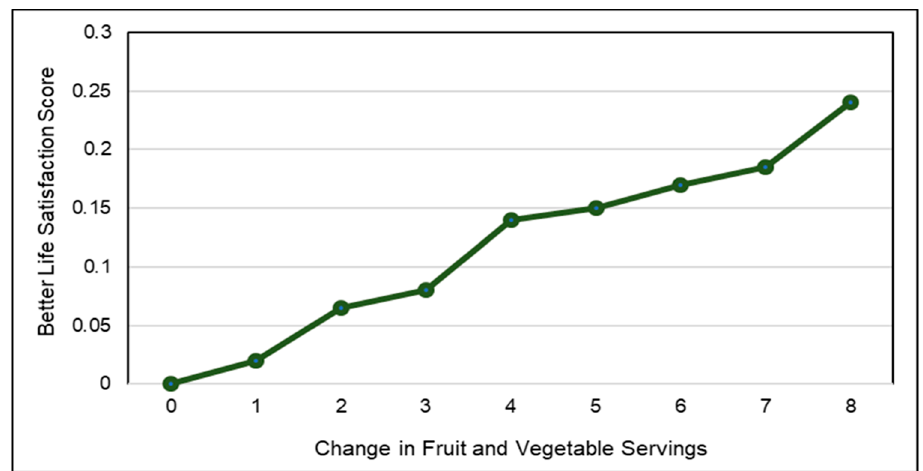
Figure 22. Association between the number of servings of fruits and vegetables/day and increases in life satisfaction ( p < 0.001) [329].